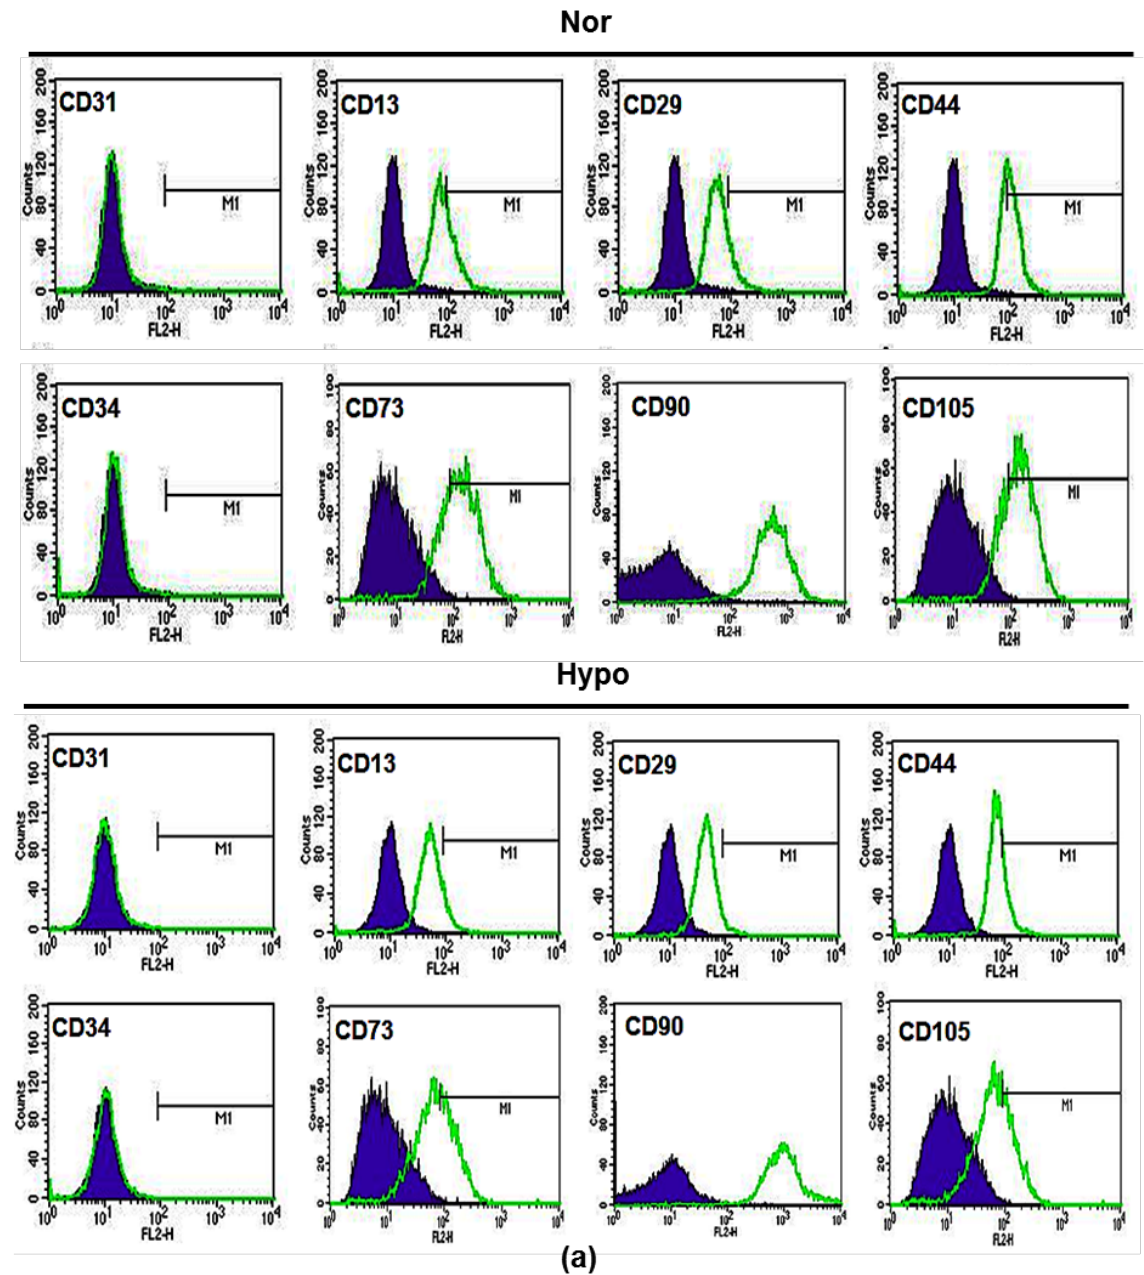
Figure 2. The effect of hypoxia on the characterization of AF-MSCs. ( a ) FACS analysis of AF-MSCs that were cultured under normoxic or hypoxic condition show similar expression of the typical MSC marker proteins CD13, CD29, CD44 and CD90, and not expression of the endothelial cell markers (CD31 and CD34); ( b ) AF-MSCs that were cultured under both normoxic and hypoxic condition differentiate to adipocyte-like cells in adipogenic induction medium after 2 weeks, which were demonstrated by Oil red O staining and the mRNA expression of adipogenic markers (LPL2, aP2 and PPARγ2); and ( c ) AF-MSCs that were cultured under both normoxic and hypoxic condition differentiate to osteoblasts-like cells in osteogenic induction medium after 3 weeks, which were demonstrated by alizarin red S staining and the mRNA expression of osteogenic markers (osteopontin and